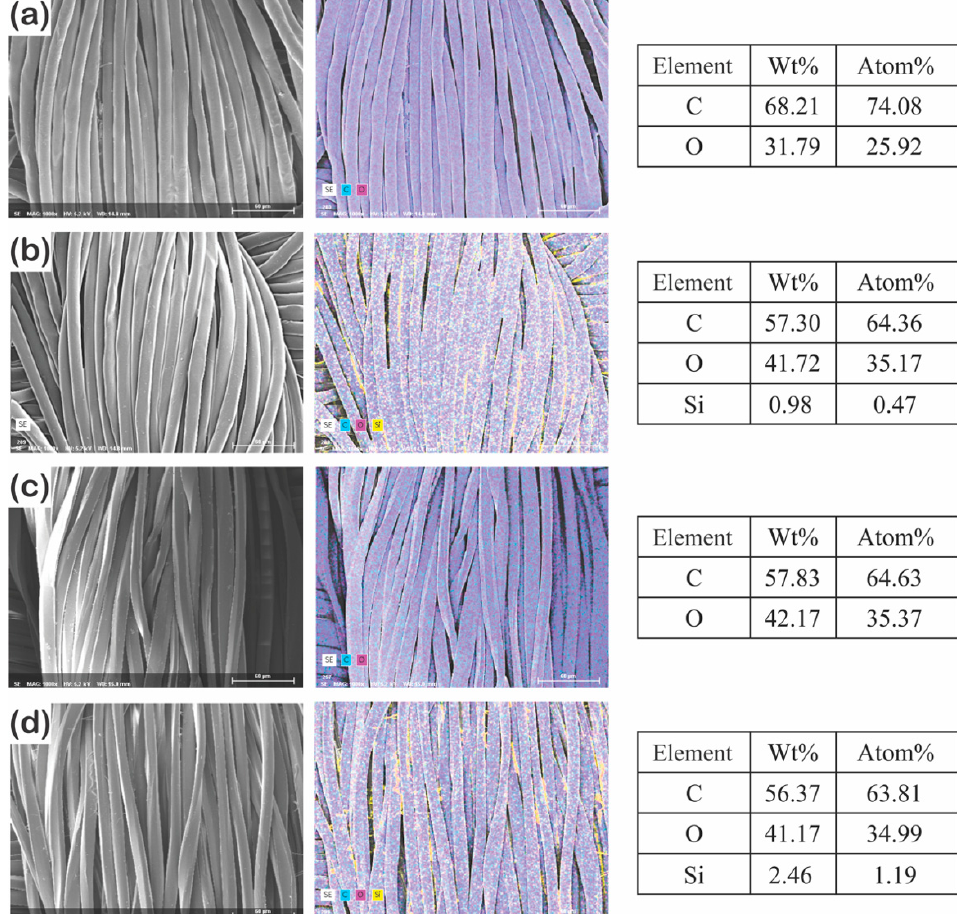
Figure 3. Surface chemical composition of untreated ( a ) and P1T1 PDMS-coated ( b ) staple fabrics and untreated ( c ) and P1T1 PDMS-coated ( d ) filament fabrics [different colors indicate different elements such as carbon ( c ) in light blue; oxygen (O) in magenta; and silicone (Si) in yellow]. (×1000).